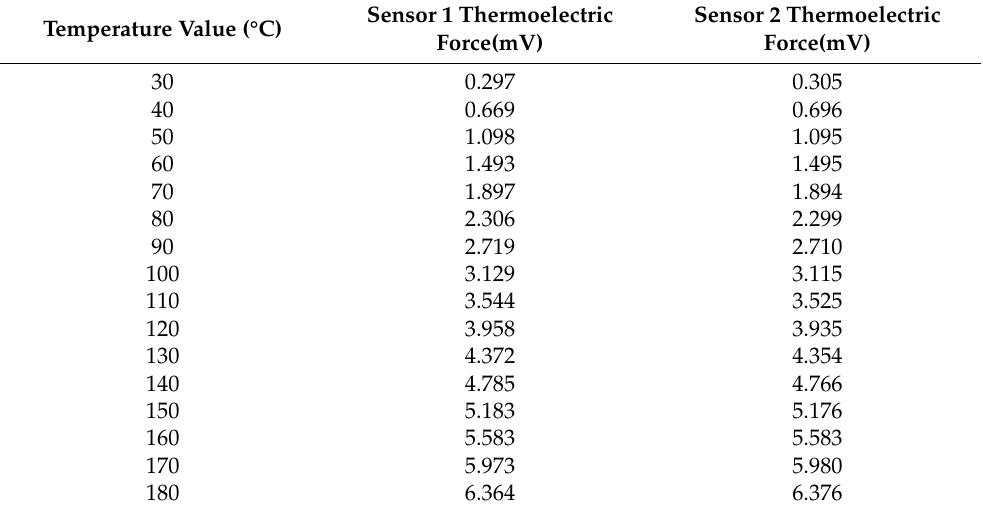
Table 4. Relationship between thermoelectric force E and the temperature of the measuring terminal T. Temperature Value